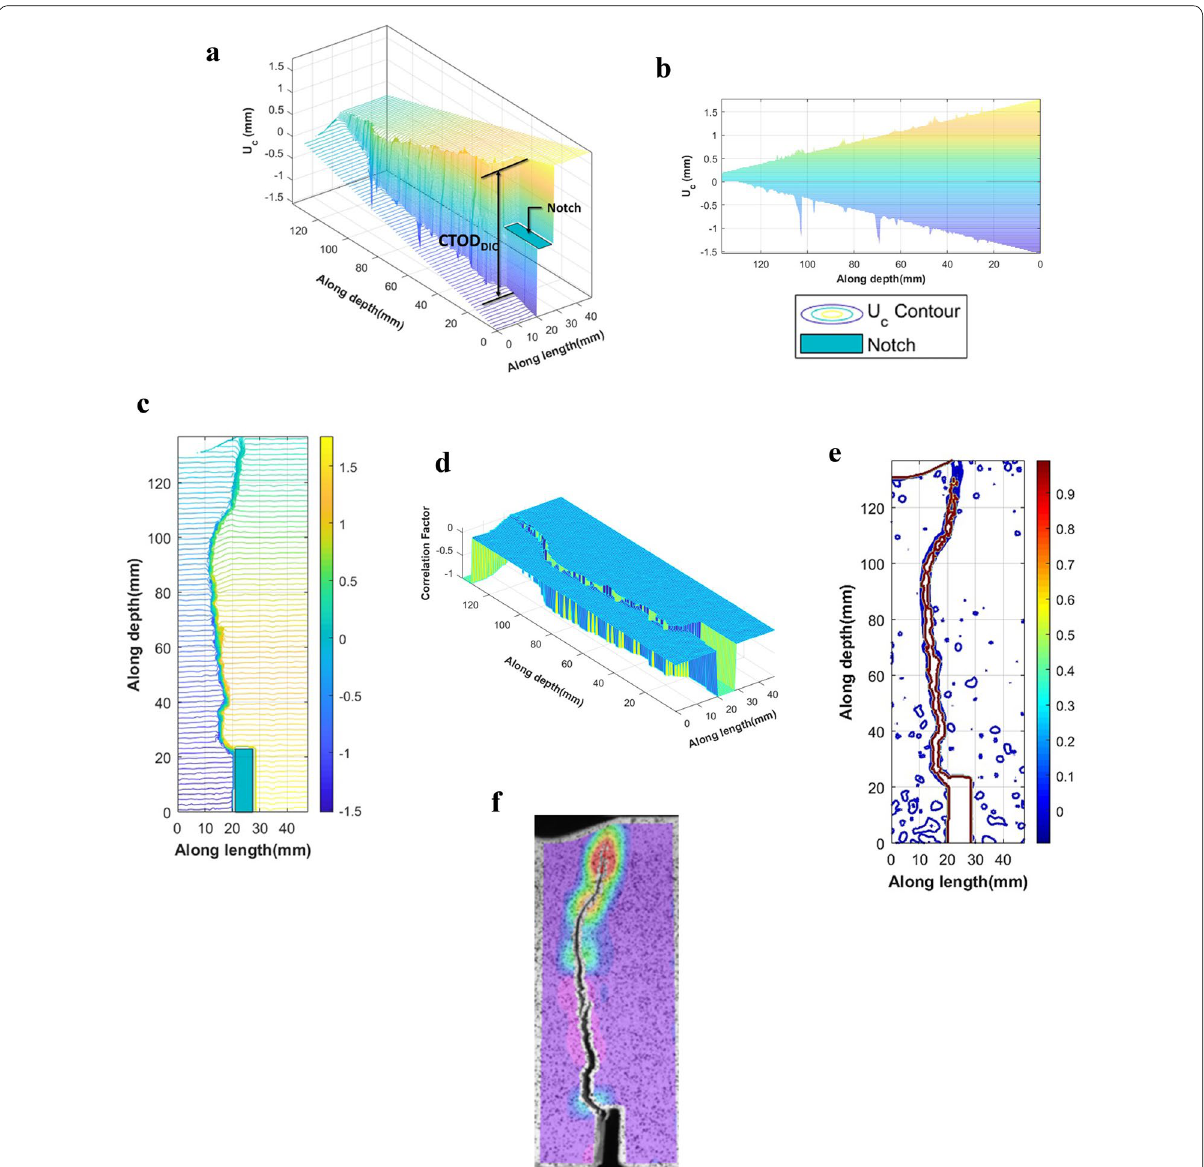
Fig. 13 Contours of correlation coefficient and visualisation of the crack opening of PO50 specimen at LP5, 4 mm CMOD: a 3D visualisation of the crack opening using contour of UC over AOI; b variation of COD along the depth (side view of 3D contour); c distribution of UC over AOI (top view of 3D contour); d coefficient of correlation over AOI showing physical opening; e the contour of the coefficient of correlation over AOI; f actual image of AOI in the specimen with ε xx